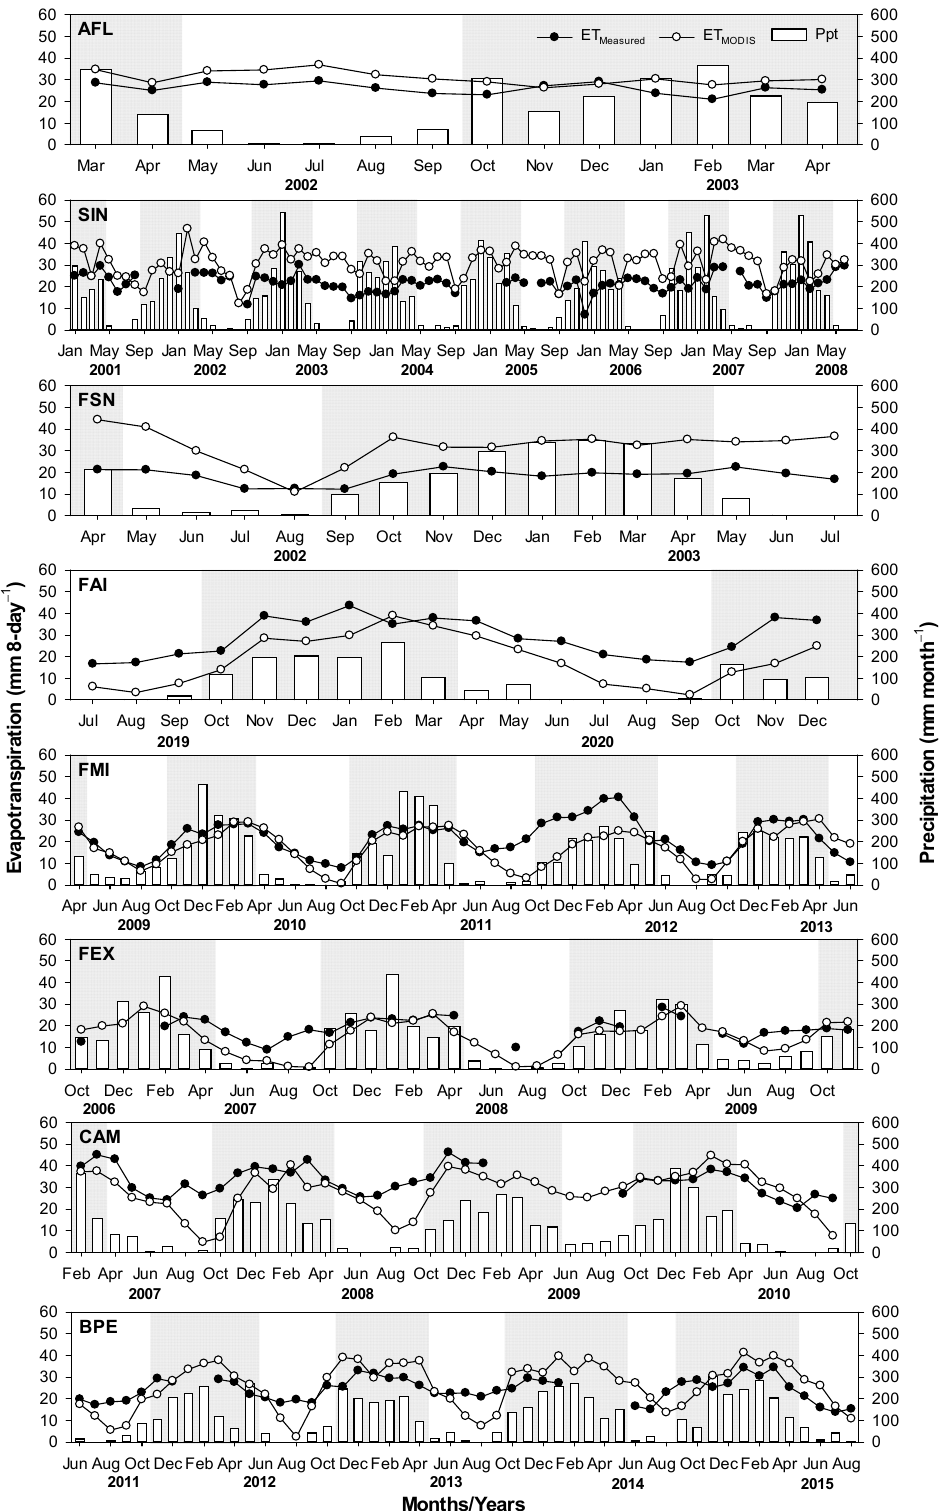
Figure 5. Monthly cumulative precipitation (Ppt) and monthly average of measured (ET Measured ) (black circles) and estimated (ET MODIS ) (white circles) evapotranspiration of cumulative 8 days (mm 8-day − 1 ), respectively, in the experimental sites located in the Amazon (AFL, SIN and FSN), Cerrado (FAI, FMI and FEX), and Pantanal (CAM and BPE). The wet seasons over each site were highlighted with a gray shaded background. A threshold of more than 100 mm of precipitation was used to identify the dry season based on [62].